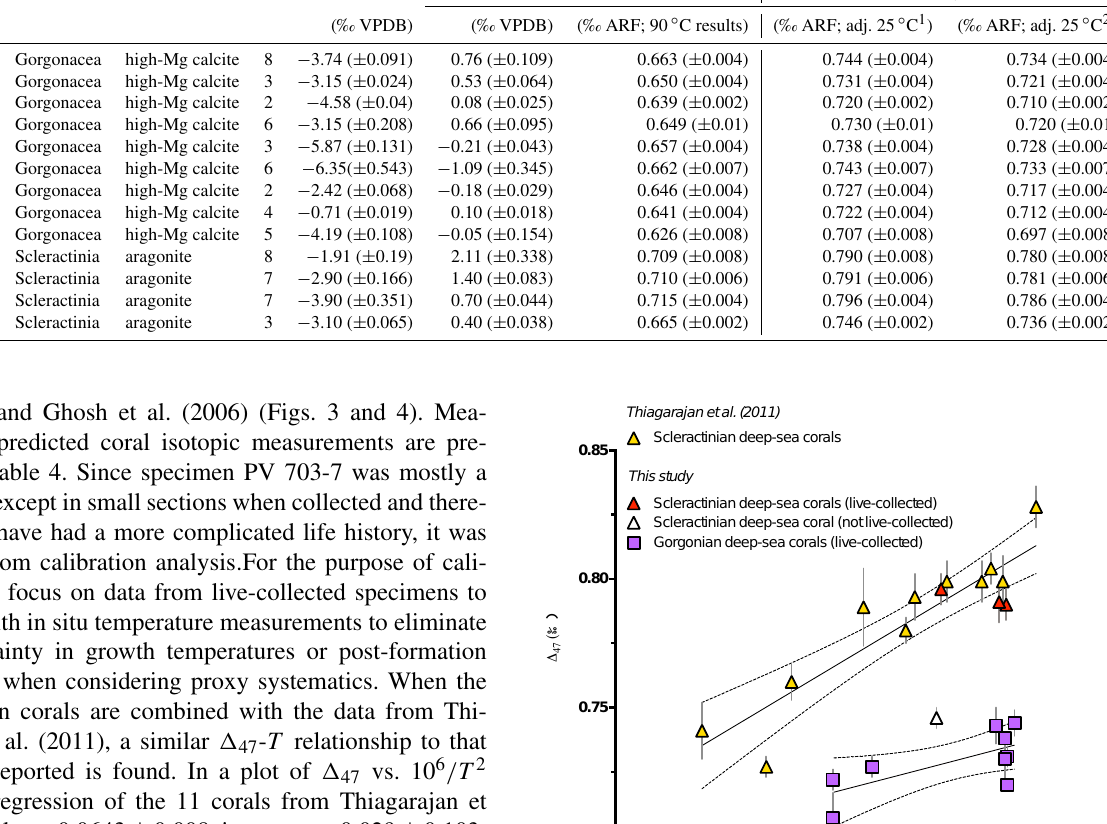
(‰ VPDB) (‰ ARF; 90 ◦ C results) (‰ ARF; adj. 25 ◦ C 1 ) (‰ ARF; adj. 25 ◦ C 2 )